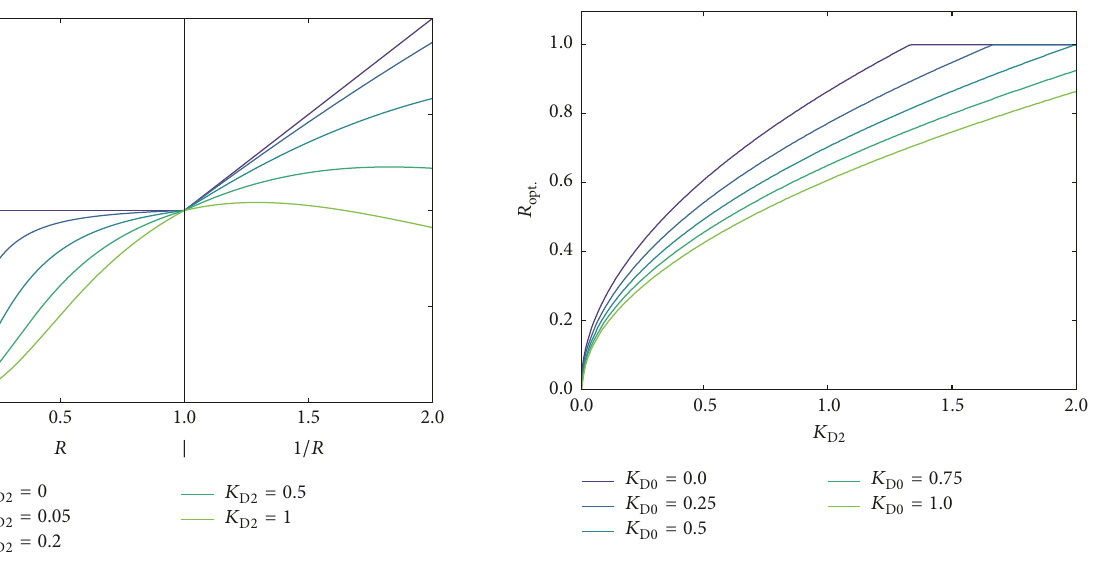
Figure 10: The ratio of maximum power coefficient 𝐶 = 𝐶 | reference value 𝐶 𝑅=1 , shown as a function of the Pmax . ref . Pmax . duct size ratio. The abscissa represents 𝑅 from values 0 to 1 and 1/𝑅 from1onwards.Thecurvesaredrawnforvariousvaluesof 𝐾 𝐾 = 0.25 . D 0